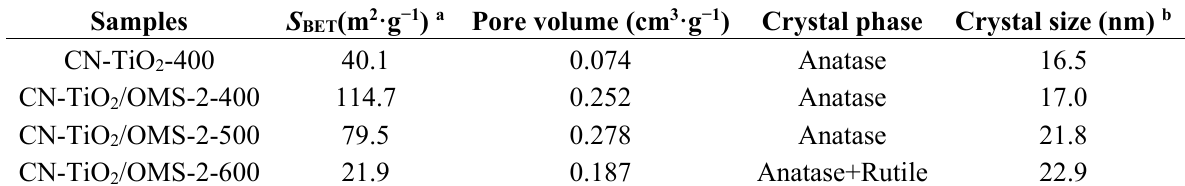
Table 1. Structural characteristics of CN-TiO 2 /OMS-2 with calcination temperature and reference material.